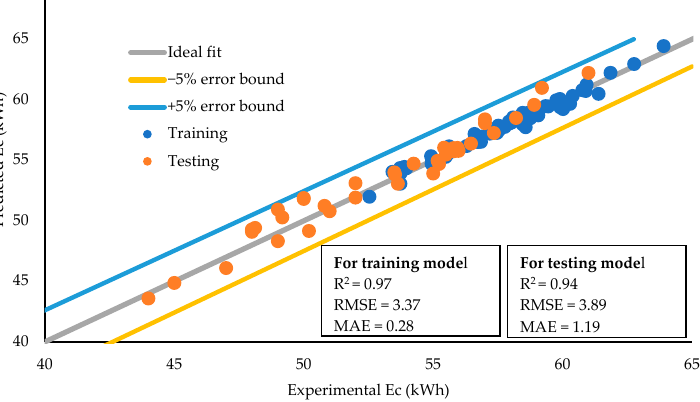
Figure 6. Performance assessment of prediction models. The statistics of the regression line of GEP model against training and testing data. The error plots between observed and predicted values are presented in Figure 7. It indicates the absolute error of the experimental data utilized for training the GEP predic- tion model and response. The results show that the average value of absolute error is 1.81 kWh which is minimal.